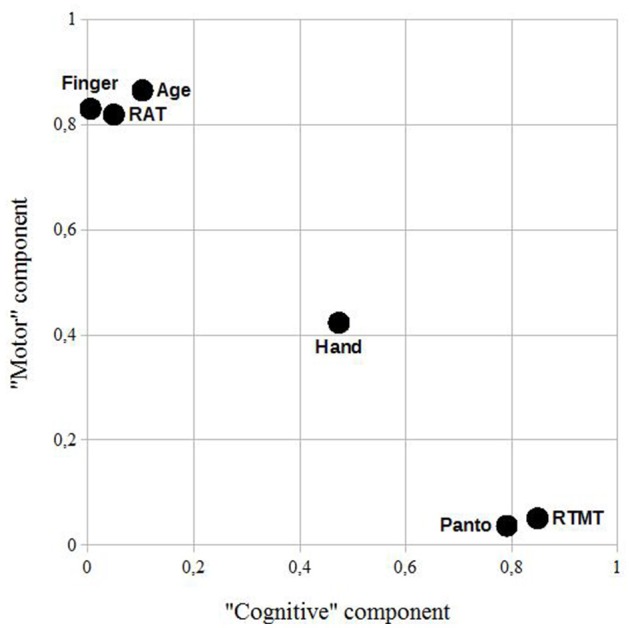
Control sample: a rotated component plot using the absolute values of the rotated component matrix for a better visual inspection. RAT, reciprocal aiming task; RTMT, reciprocal trail making task; Finger, imitation of finger constellations; Hand, imitation of meaningless gestures; Panto, pantomime of the use of everyday objects.